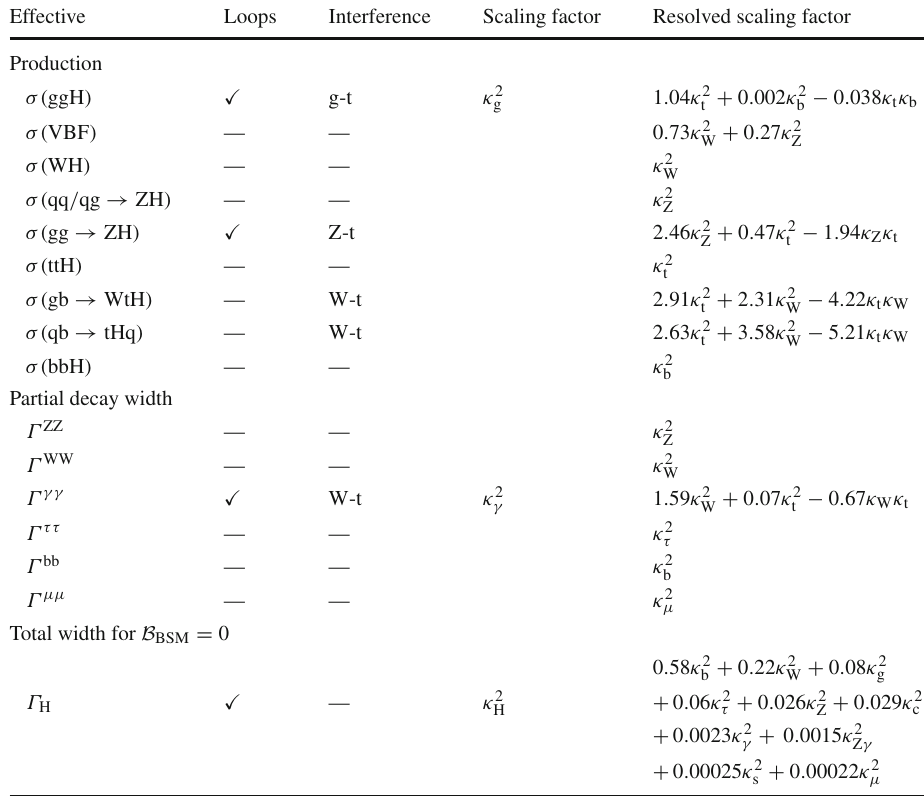
Table 6 Normalization scaling factors for all relevant production cross sections and decay partial widths. For the κ parameters representing loop processes, the resolved scaling in terms of the fundamental SM couplings is also given